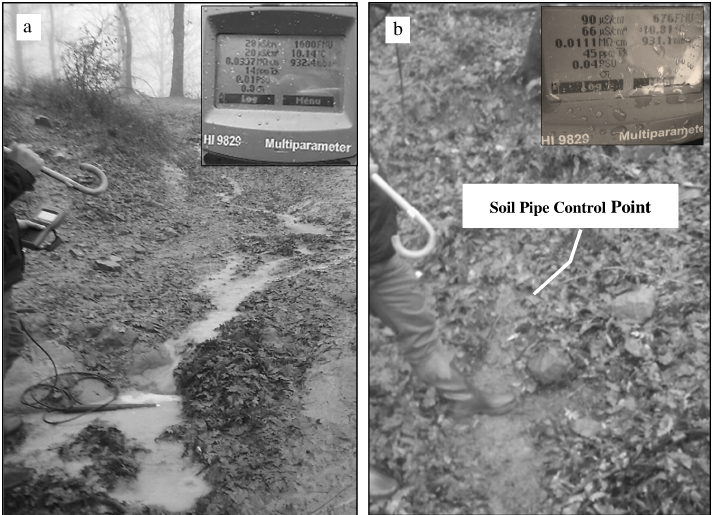
Figure 5. Measurements at 12:00 in the dirt road point controls (a) and the soil pipe (b) with respective EC values.